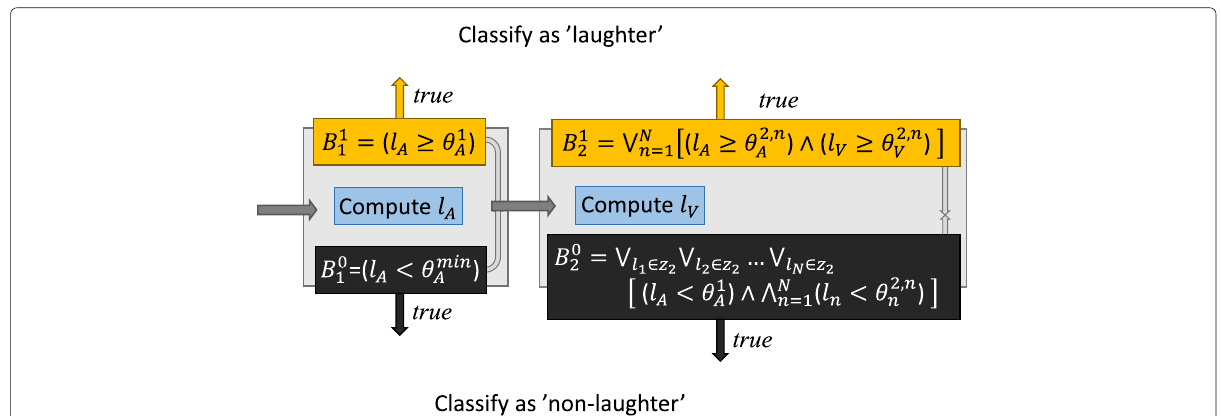
Fig. 7 Symmetrical BOA cascade for laughter detection. Symmetrical BOA cascade, which is capable of making early classification to both classes, realizing of BOA (15) for laughter detection. The conjunction set z 2 = { l A , l V } and the threshold θ min contains K = 2 N conjunctions, where the first threshold comparison is always l A or l V according to binary ( M 2 -ary) N -digit representation of the conjunction index k = 1 ... K , bin ( k ) . If the n :th digit of bin ( k ) is 0, l A is used, and l V is used if the n :th digit of bin ( k ) is